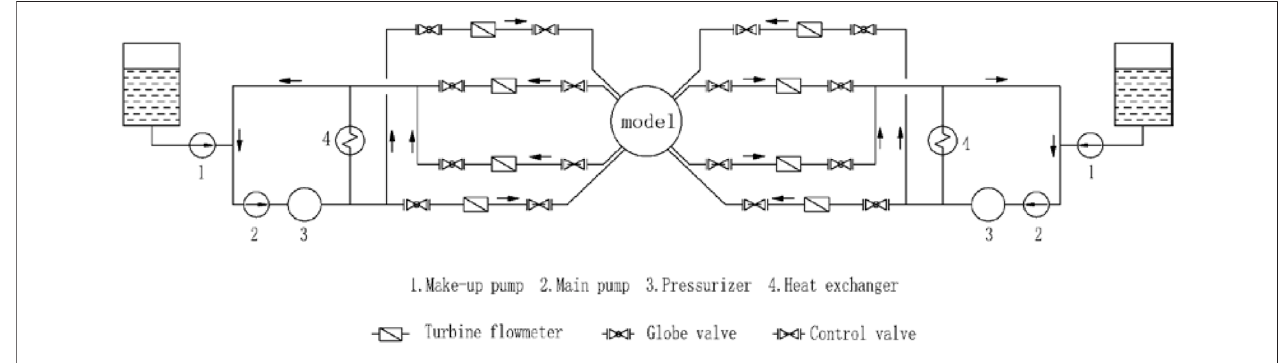
FIGURE 6 | schematic diagram of test loop.